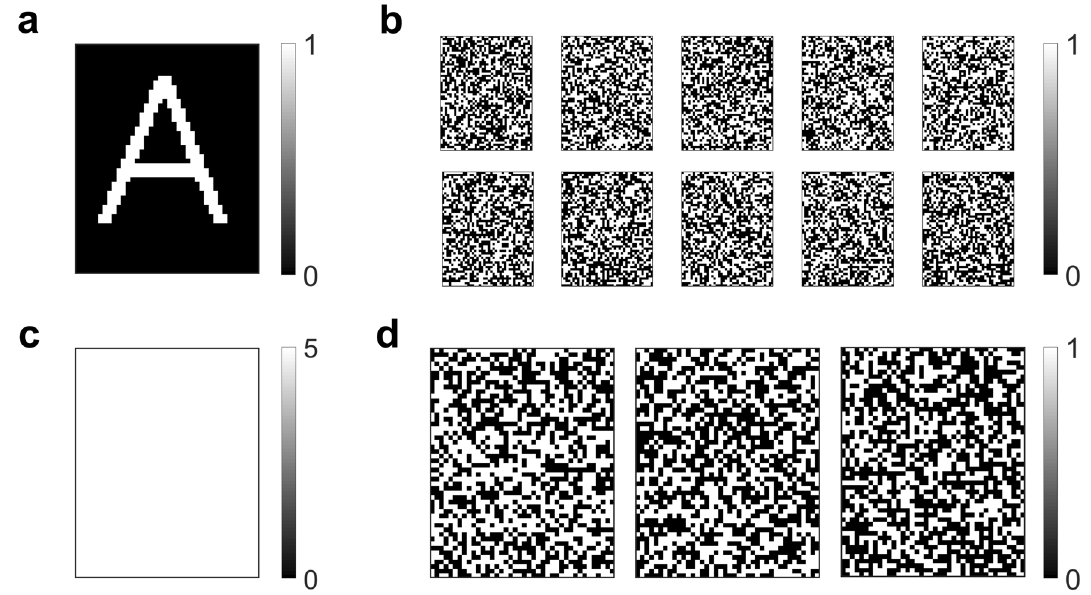
Figure 4. Encryption using optimal system parameters. (a) A 50 × 40 pixel binary image of the letter ‘A’. ( b) Cipher images generated by encrypting the letter ‘A’ image using a key with n = 10, n p = 5 and n s = 126. ( c) Image representing the sum of all cipher images. ( d) Images generated by attempting decryption using three incorrect keys with n = 10, n p = 5 and n s =